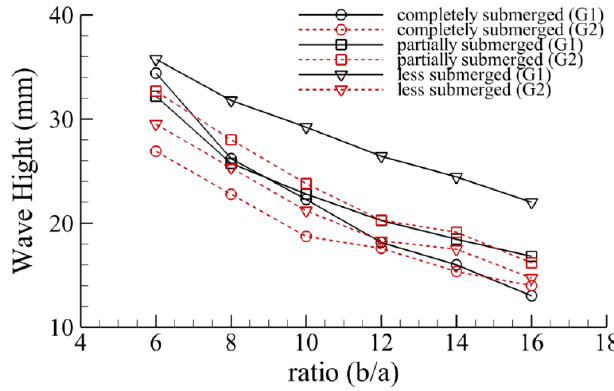
Figure 19. The change of the maximum wave height with R.